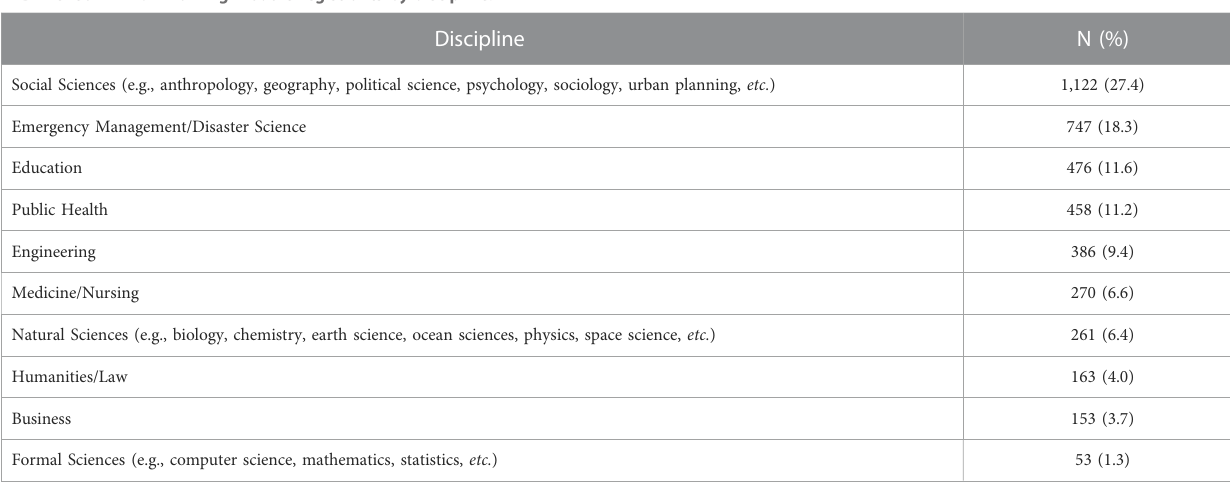
TABLE 3 CONVERGE Training Module registrants by discipline.